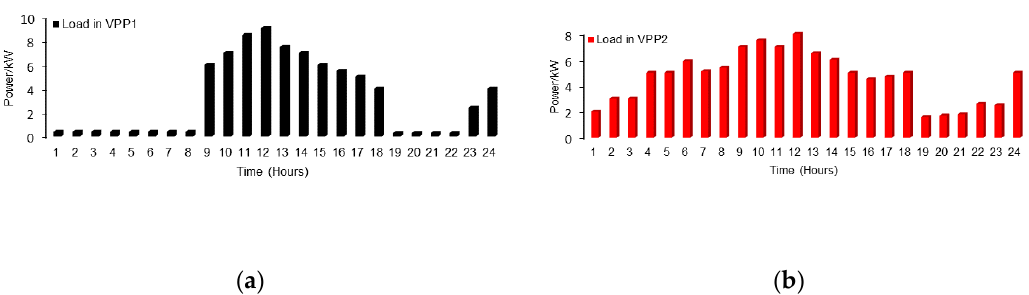
Table 3. Electricity tariffs (unit: $/kWh).